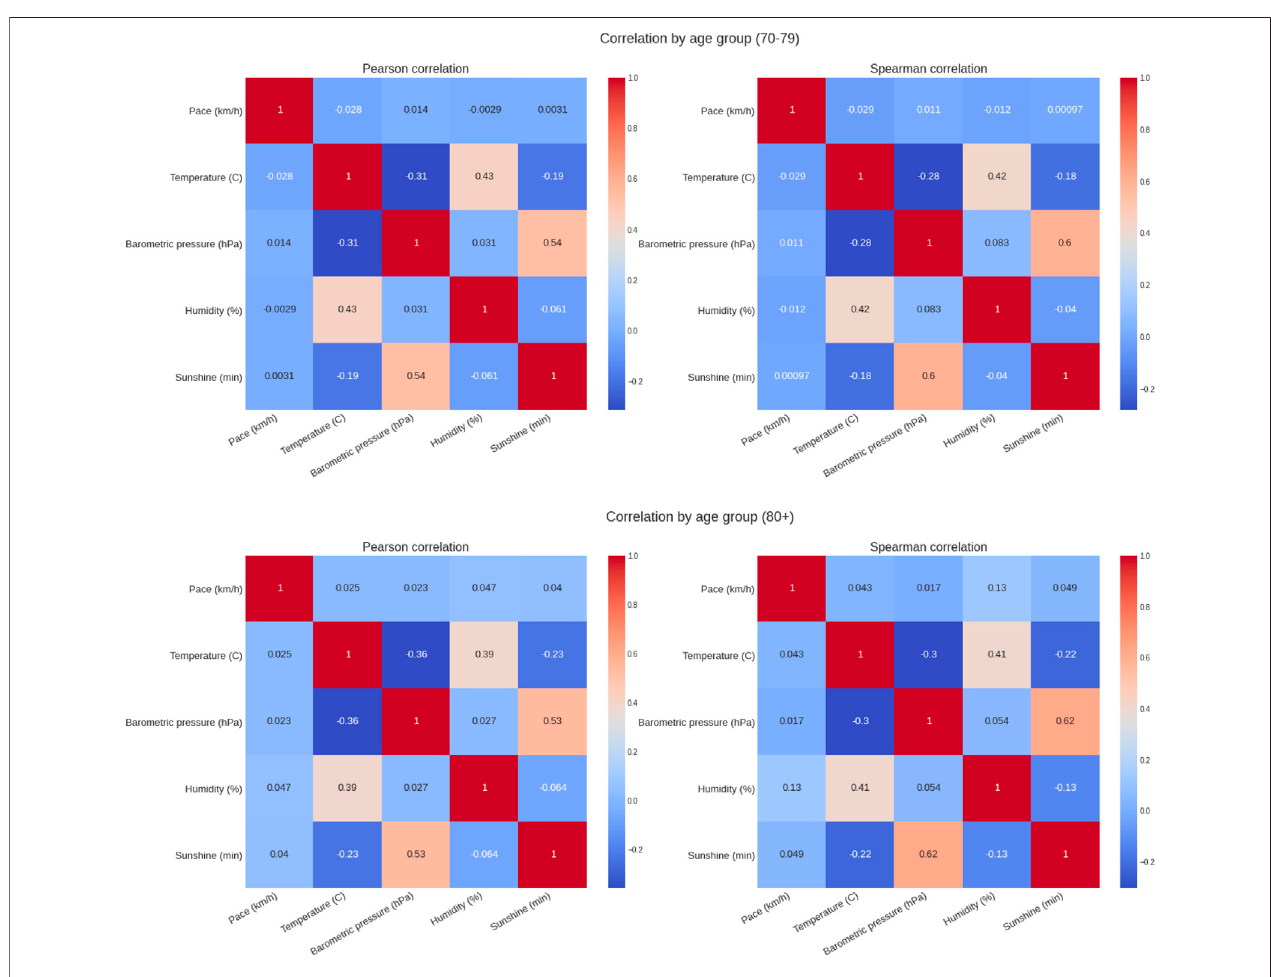
FIGURE 8 | Correlation between running speed and average weather variables by age groups.